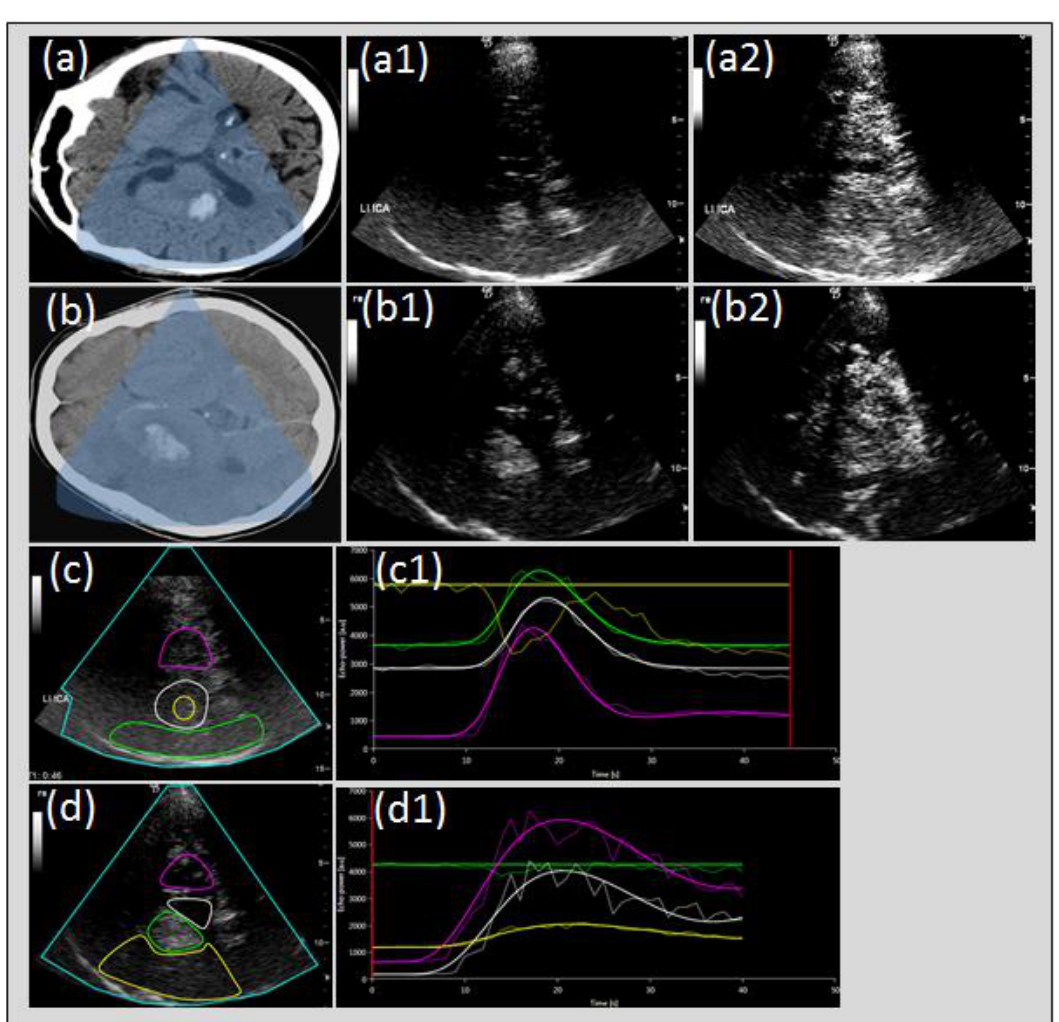
Figure 7. Perfusion imaging in intracerebral hemorrhage and hemorrhagic transformation of cerebral infarction. Cerebral CT of intracerebral hemorrhage (ICH) of the right basal ganglia, ( a ) native transcranial gray-scale sonography with hyperechogenic depiction of ICH ( a1 ) and UPI with relative hypo-echogenicity of ICH compared to contrast perfusion of cerebral tissue ( a2 ) due to non-perfusion constricted to the hemorrhagic lesion ( c , c1 ). Cerebral CT of ICH due to hemorrhagic transformation ( b ), native transcranial gray-scale sonography with hyperechogenic depiction of hemorrhagic transformation ( b1 ) and UPI with persistent hyperechogenicity of the hemorrhagic lesion due to omitted perfusion of the surrounding tissue due to acute stroke ( b2 ) with slowed or missing tissue perfusion ( b2 )( d , d1 ).